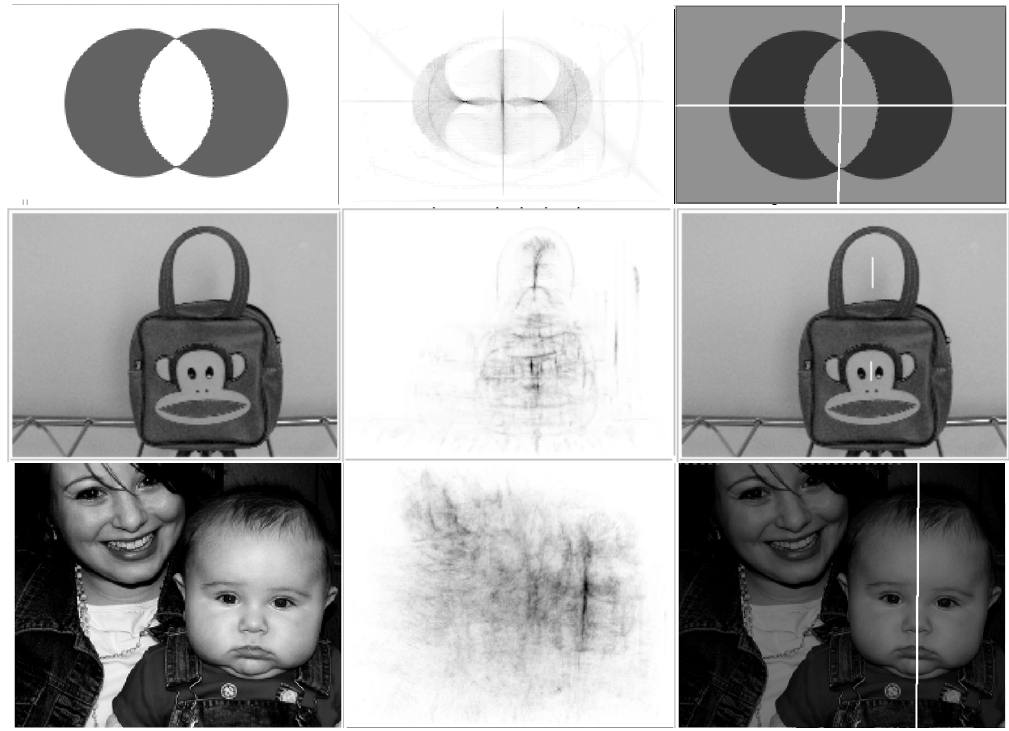
Figure 5. Bilateral symmetry with the original images on the left, resulting symmetry map in the centre and the resulting axes of symmetry superimposed over the original on the right.